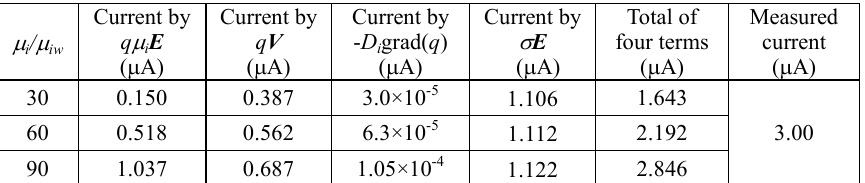
Fig.8 Comparison of measured p-Q characteristic with simulated one (standard pump, k =7.10×10 -9 C/(V ･ m 2 ), µ Table2 Contribution of each term in Eq.(5) to current and comparison between measured and simulated currents ( V =10kV, Q